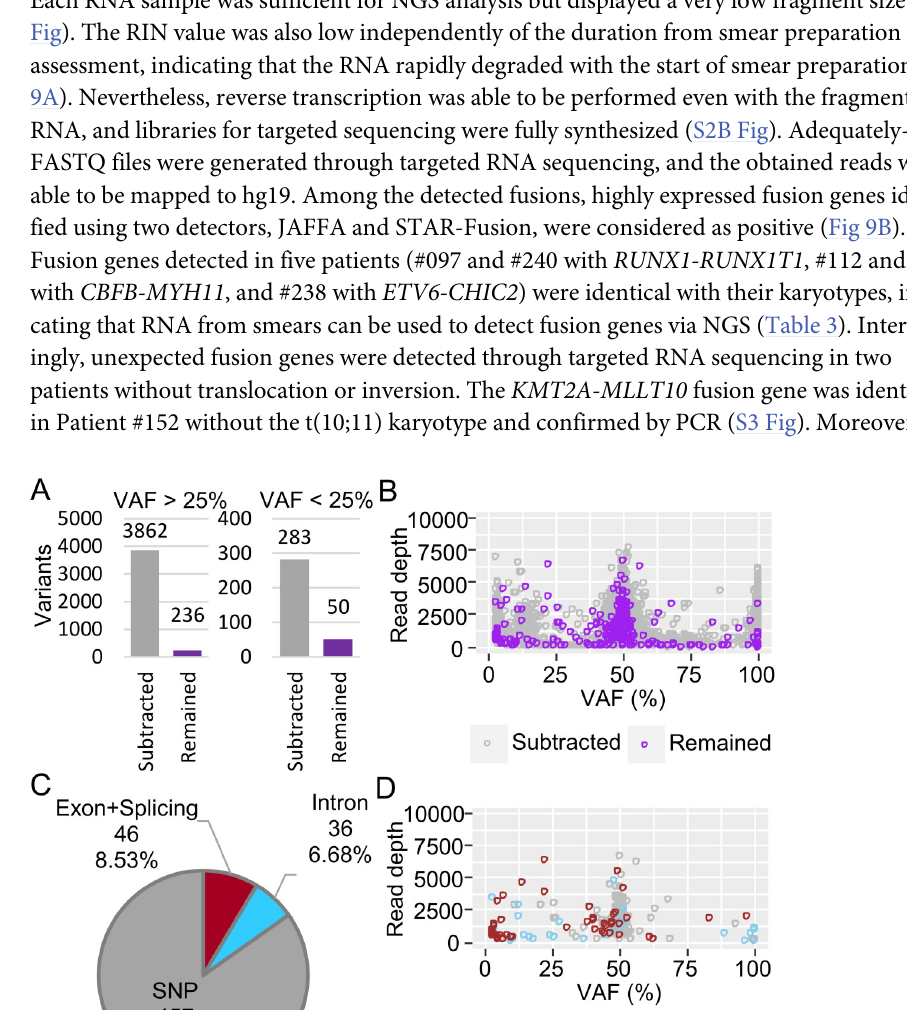
Fig 6. Filtering effect on the variants detected using Mutect2 in Fig 4. (A) Pie chart of the smear-unique, BMC- unique, and shared variants after filtering. (B) Distribution of the filtered variants. VAF, variant allele frequency. The smear-unique, BMC-unique, and shared variants were color-coded. (C) VAF plot of filtered variants in the BMC (X axis) and smear (Y axis) samples.